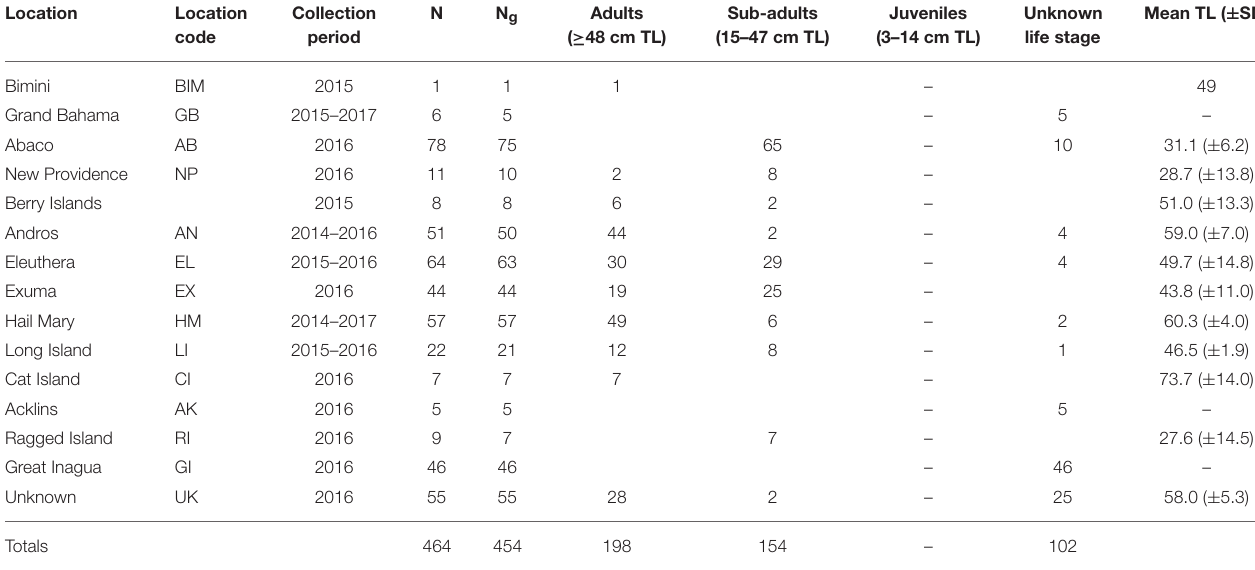
TABLE 1 | Sampling information for Nassau grouper specimens including a breakdown of the number of fin clips = N, number of genotypes = N g , life stages for genotyped fish, and the mean total length (TL) ± standard deviation (SD) of fish measured in each location.